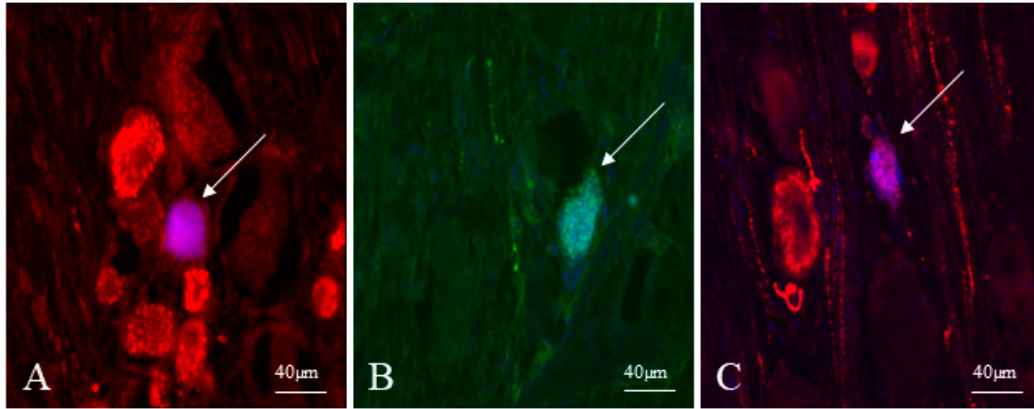
Figure 2. Fast blue-positive neurons in the dorsal root ganglia (DRG) supplying the ileocecal valve (ICV) (indicated with arrows) immunoreactive to calcitonin gene related peptide (CGRP) ( A ), substance P (SP) ( B ) and galanin (GAL) ( C ).